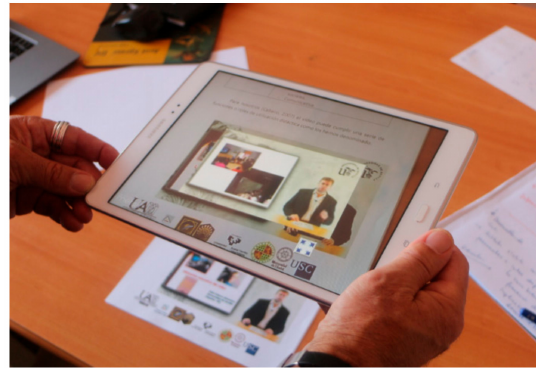
Figure 1. Image of the Augmented Reality (AR) object and its utilization in “Educational Technology”. Four AR objects were created for the “Anatomy” area, namely: Coxofemoral2; Shoulde2r; Ankle2; and Cervical2. All of them shared the following features: 3D animations; stop and monitoring of the object; enlargement of the size of the component presented so that details become visible; and transfer to an information extending video located on YouTube (Figure